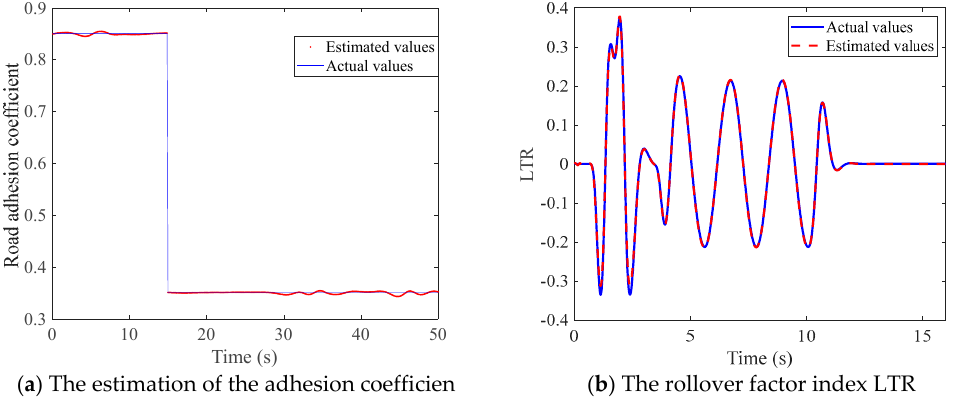
Figure 11. The estimation of the adhesion coefficient and LTR from dry asphalt to ice and snow.